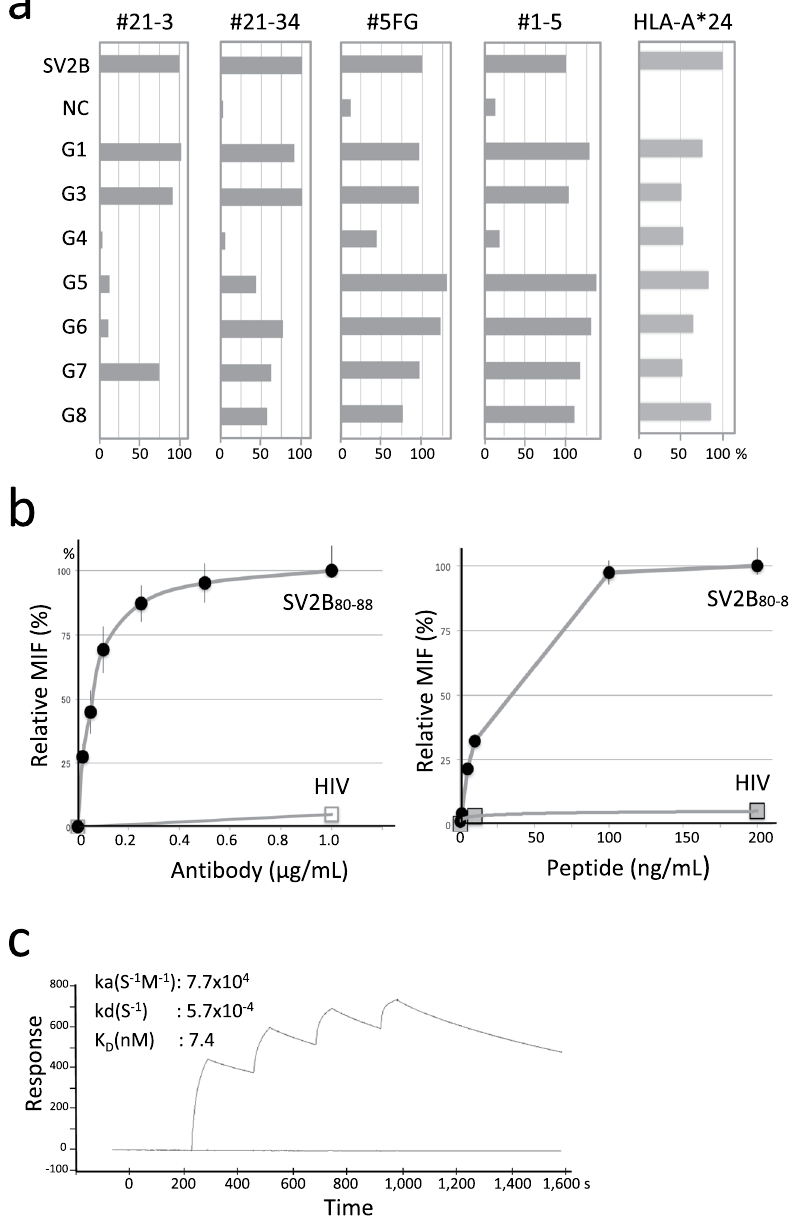
Figure 2. Characterization of binding specificity of #21-3 against SV2B 80-88 /HLA-A * 24. ( a ) Epitope mapping of the candidate mAbs based on glycine-substituted SV2B 80-88 peptides. Each non-anchor residue in the SV2B 80-88 was substituted for glycine, and peptides were pulsed onto T2/24 cells. Binding of the mAbs was determined by FACS relative to native SV2B 80-88 -pulsed T2/A24 cells. T2/A24 cells (1 × 10 5 ) pulsed with either SV2B 80-88 or glycine-substituted SV2B 80-88 peptides (0.2 µ g/mL) are incubated with the selected mAbs (0.1 µ g/mL) and the PE-labeled anti-HLA-A * 24 mAb. The antibody binding was evaluated by MFI of the stained T2/A24 cells. NC, T2 cells without peptide. Values are represented by the means of two independent experiments for two replicates/group. ( b ) Binding of #21-3 to SV2B 80-88 /HAL-A * 24 on T2/A24 cells. T2/A24 cells pulsed with the SV2B 80-88 or HIV at 0.2 µ g/mL were stained with #21-3 at the indicated concentrations (upper panel). T2/A24 cells pulsed with the SV2B 80-88 at various concentrations were stained with #21-3 at 1.0 μ g/mL. HIV pulsing at 0.2 µ g/mL was used as a control (lower panel). Relative MFI of the staining were plotted. Data in each panel is representative of two independent experiments (n = 3). ( c ) SPR analysis of #21-3 for affinity to SV2B 80-88 /HLA- A * 24. Calculated affinity constants are displayed. Data are representative of two independent